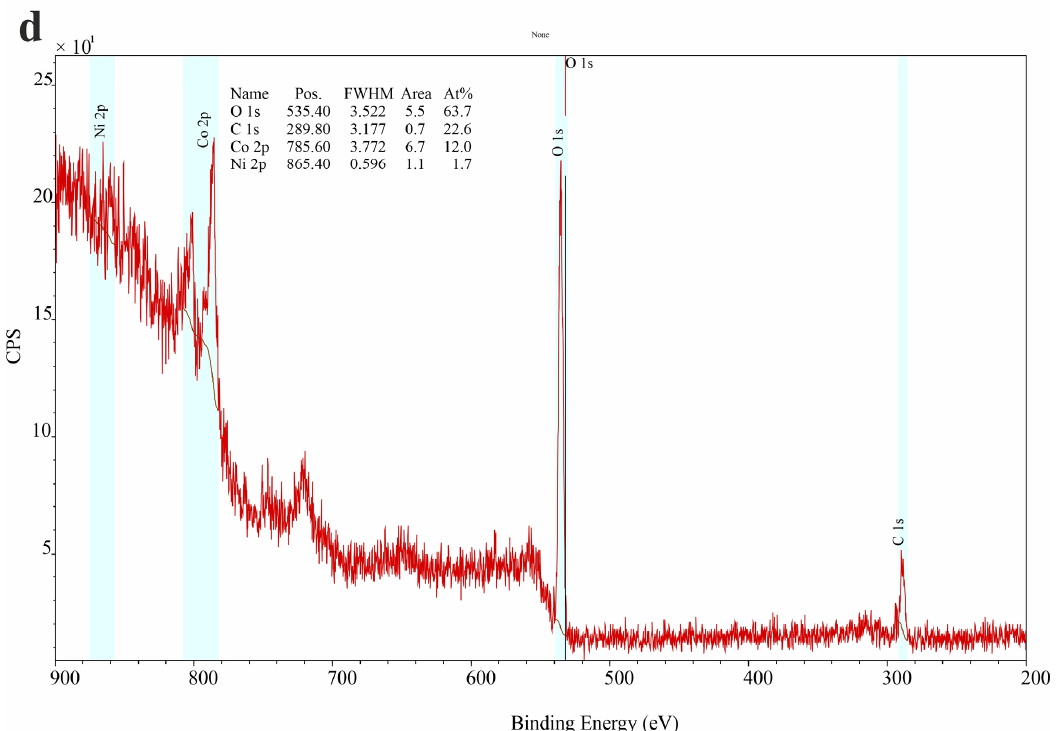
Figure 7. EDX spectra and the compositions for the samples: ( a ) Ni(OH) 2 -pure; ( b ) Ni(OH) 2 -PVP; ( c ) Ni(OH) 2 -PVP-Co-elchem; ( d ) Ni(OH) 2 -PVP-Co-chem. Coatings 2023 , 13 , x FOR PEER REVIEW